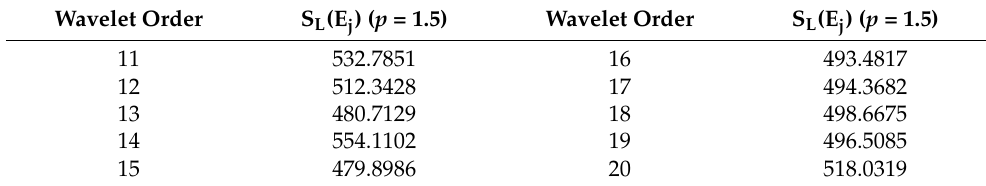
Table 1. Cost function values for decomposing Daubechies with level 4. Wavelet Order